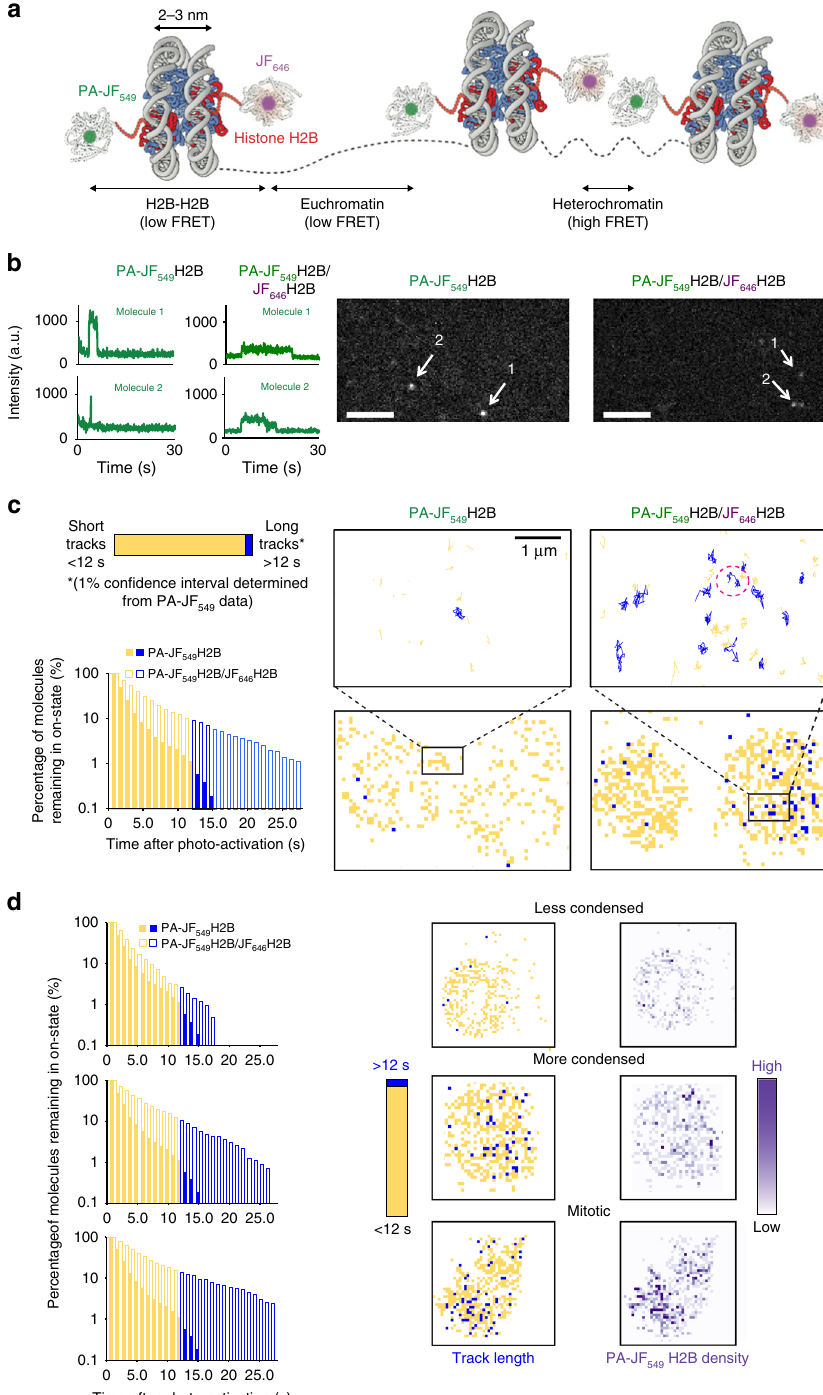
Fig. 5 FRET-enhanced PA-JF 549 allows tracking of single H2B complexes. a Schematic showing one histone H2B molecule in a nucleosome labeled with a donor PA-JF 549 , and a second labeled with an acceptor JF 646 such that FRET occurs either within a nucleosome or between nucleosomes when they are in close spatial proximity. The reduced inter-nucleosome distance in heterochromatin leads to higher FRET ef fi ciency. b Representative images and intensity vs. time traces of single PA-JF 549 -tagged H2B molecules are shown in the absence or presence of JF 646 -labeled H2B (scale bar = 5 µ m). c Single PA-JF 549 - tagged H2B nucleosomes show increased track length in the presence of JF 646 -tagged H2B. A 1% con fi dence interval was de fi ned to show whether average trajectory lengths were below (yellow) or above 12 s (blue) — only 1% of PA-JF 549 -tagged molecules have average track lengths longer than 12 s. Density maps were generated to show where the long trajectories are concentrated, and representative examples of long trajectories are shown in the upper panels in the same colors, where the one circled in red shows long periods of con fi ned motion interrupted by a short period of rapid linear motion. d Inter-nuclear differences in track length were observed (left) for three different cells with less condensed, more condensed, or mitotic chromatin (top to bottom). Density maps show that regions where track lengths were on average above the 12-s cutoff (middle) also had a high number of localized PA-JF 549 -tagged H2B molecules